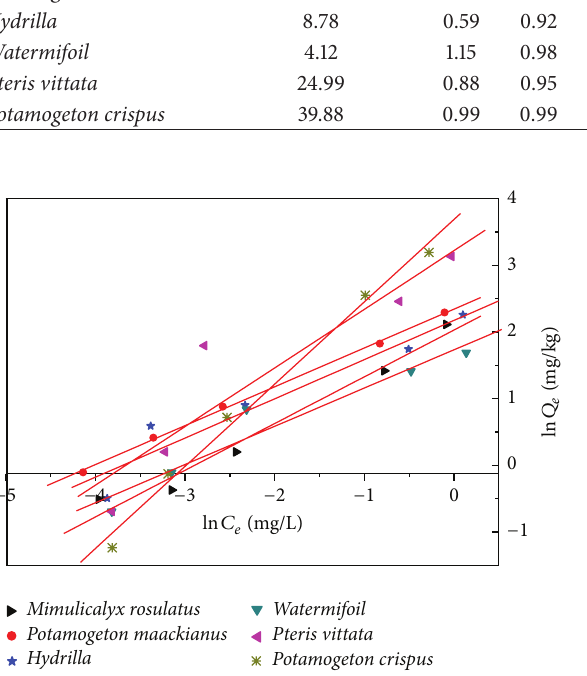
Figure 3: The linearized D-R adsorption isotherms of As (III) by the submerged